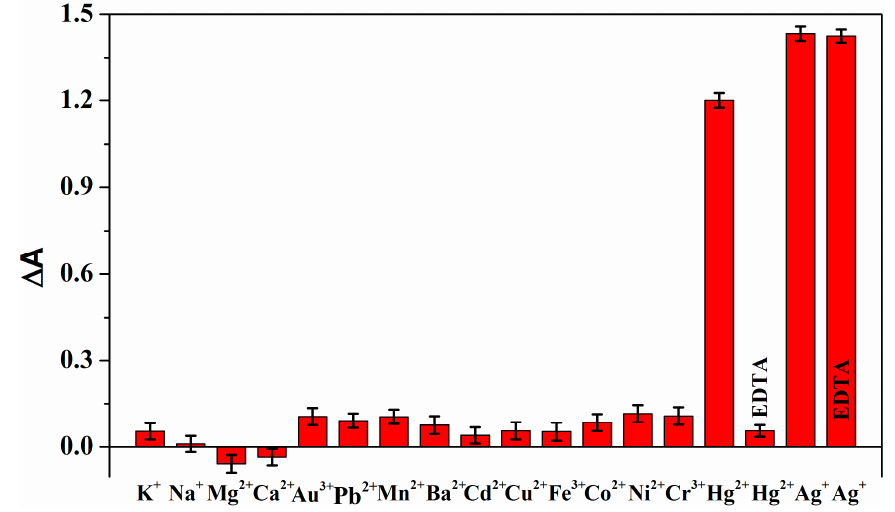
Figure 10. Selectivity investigation of the proposed sensor for Ag + detection (the concentration of K + , Na + , Mg 2+ , Ca 2+ : 0.5 mM, Ag + and Hg 2+ : 10 nM, other ions: 1.0 µM).